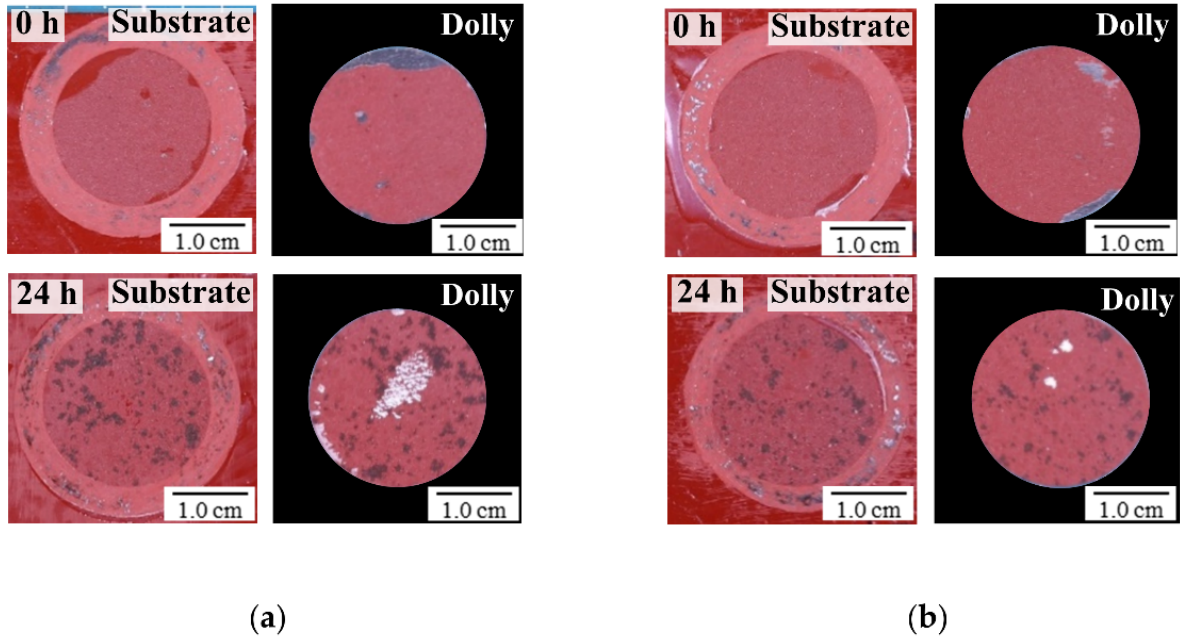
Figure 18. Fracture surface conditions after the adhesion tests on the painted surfaces after 0 and 24 h exposure: ( a ) CST, ( b ) CAL.